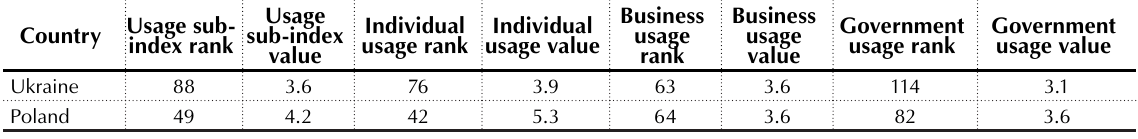
Table 9. Impact sub-index and pillars of Ukraine and Poland